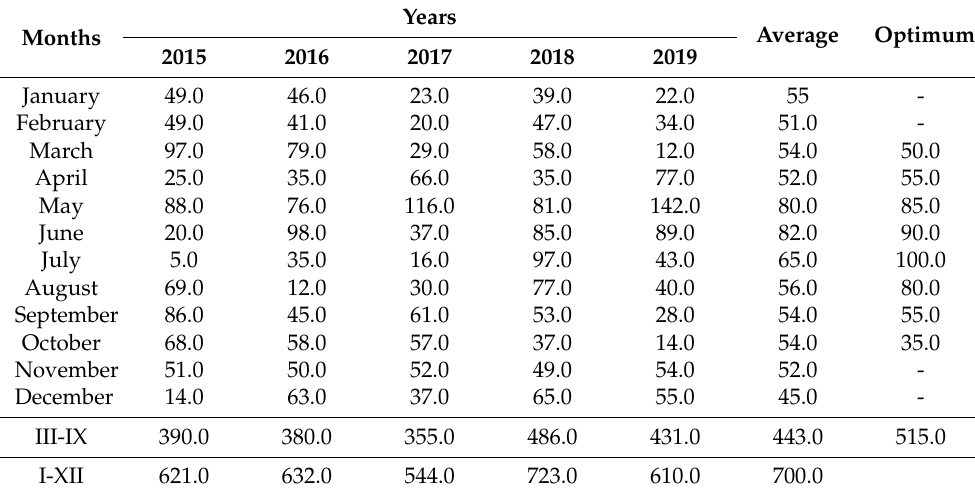
Table 1. Quantities and distribution of precipitation (mm) during